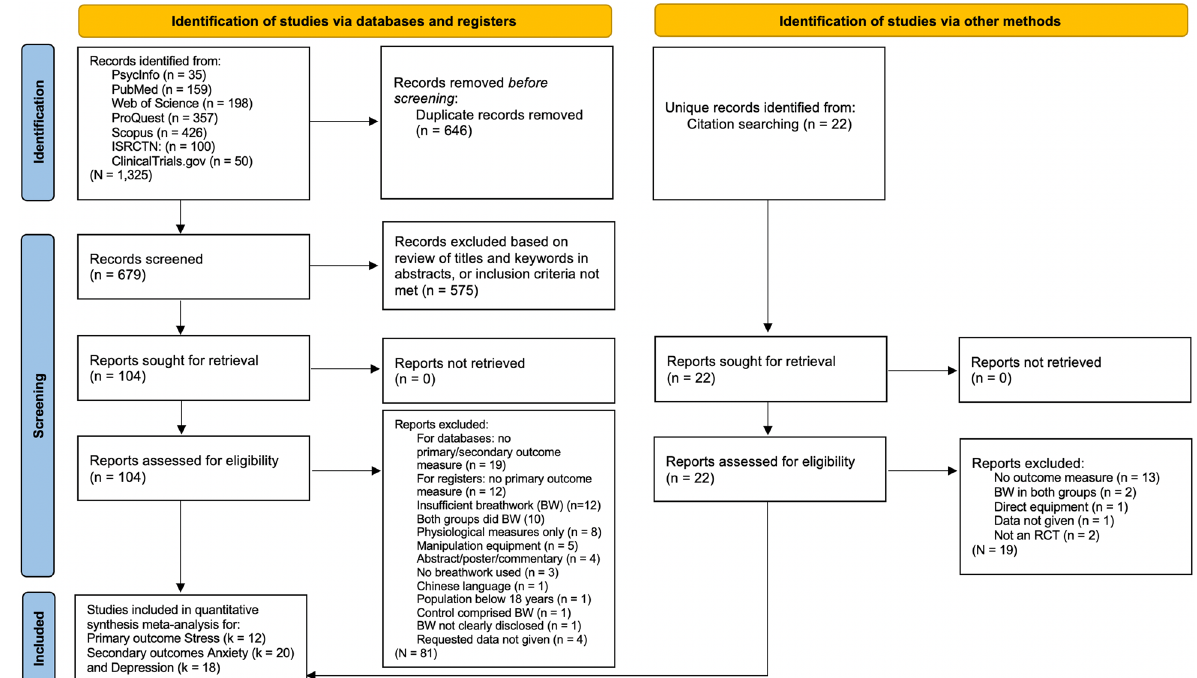
Figure 1. PRISMA flow diagram showing the identification of eligible studies via databases, registers, and citation searching. Self-reported/subjective stress was the primary outcome for the quantitative synthesis random-effects meta-analysis. Total number of included studies was 26. Trial registries searched primary outcome